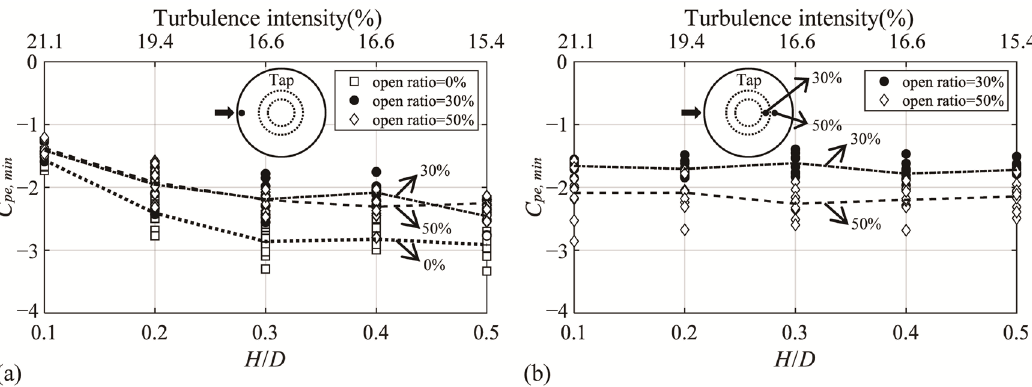
Figure 10. C pe, min according to the turbulence intensity (tap at the location affected by separation): ( a ) windward region and ( b ) edge of the roof on the center of the dome.